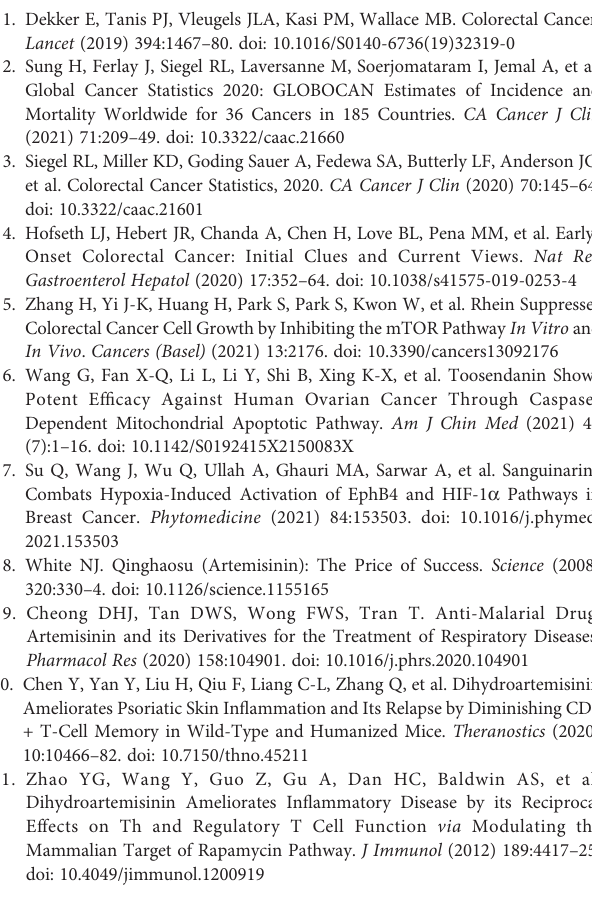
Supplementary Figure 1 | Expression levels of CDK1, CCNB1, and PLK1 in different malignant tumors. (A – C) The expression of CDK1, CCNB1, and PLK1 in